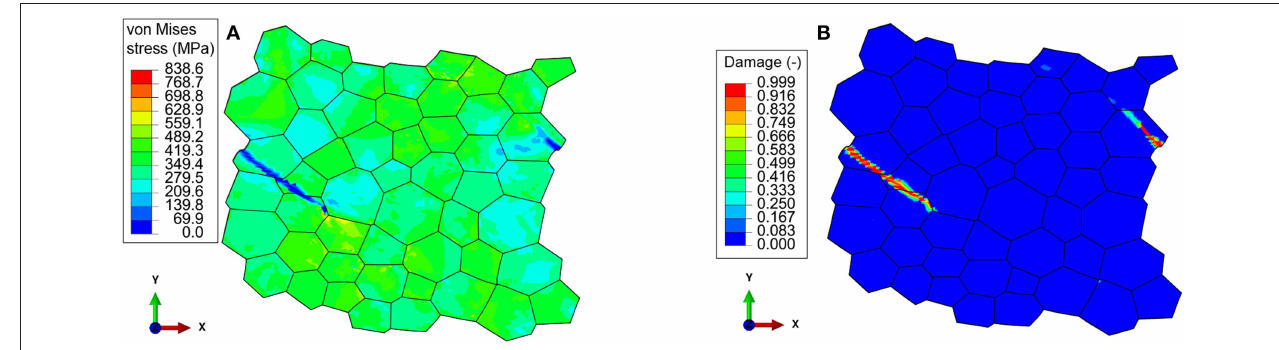
FIGURE 4 | Contour plot of the (A) von Mises stress and (B) damage parameter for uniaxial tension in x-direction at about 14.3 % total